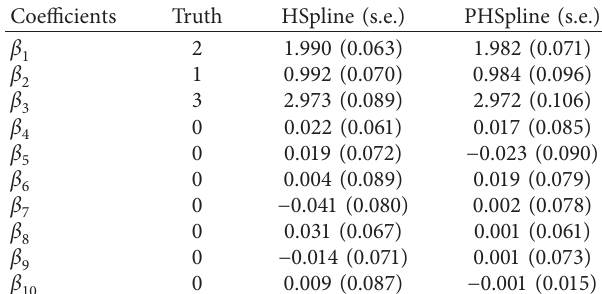
Table 8: Simulation result of Example